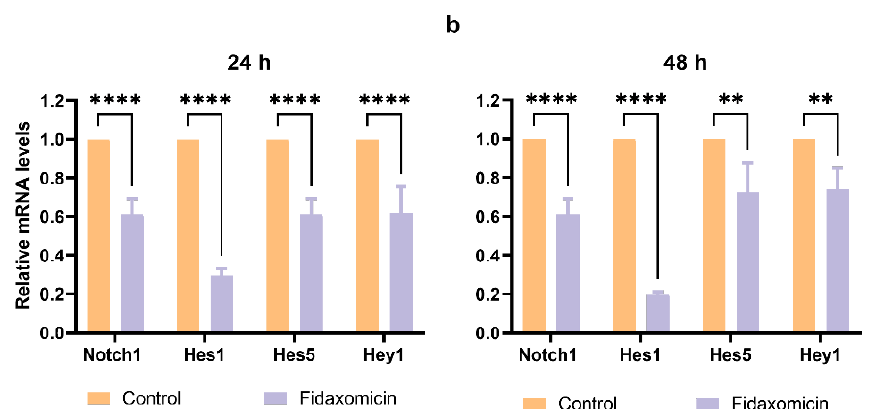
Figure 7. The mRNA levels of Notch target genes in 4T1 cells after incubation with fidaxomicin for a variety of times. ( a ) The results of a 24 h incubation with fidaxomicin; ( b ) the results of a 48 h incubation with fidaxomicin. qRT-PCR analysis revealed that the incubation of fidaxomicin significantly reduced the mRNA levels of Notch1, as well as Notch target genes Hes1, Hes5, and Hey1. Data shown represent the mean ± SD of triplicate experiments (** p < 0.01, and **** p < 0.0001 vs. control group).